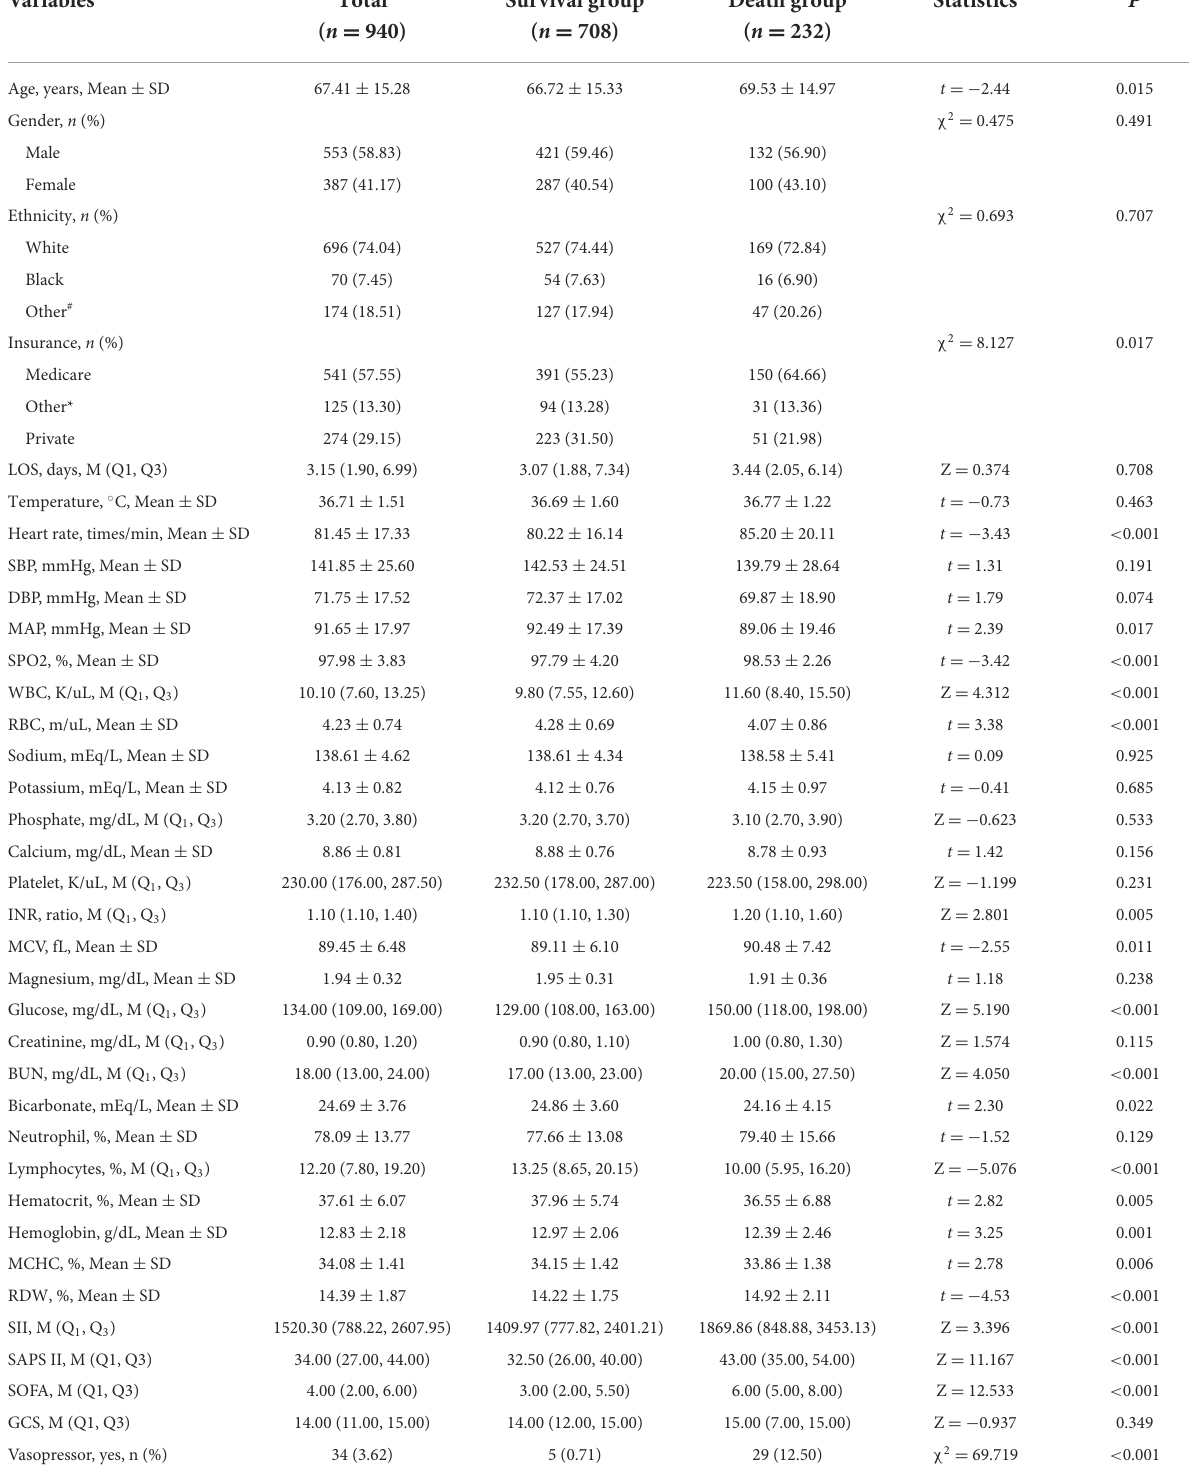
TABLE 1 The characteristics of included patients in the training